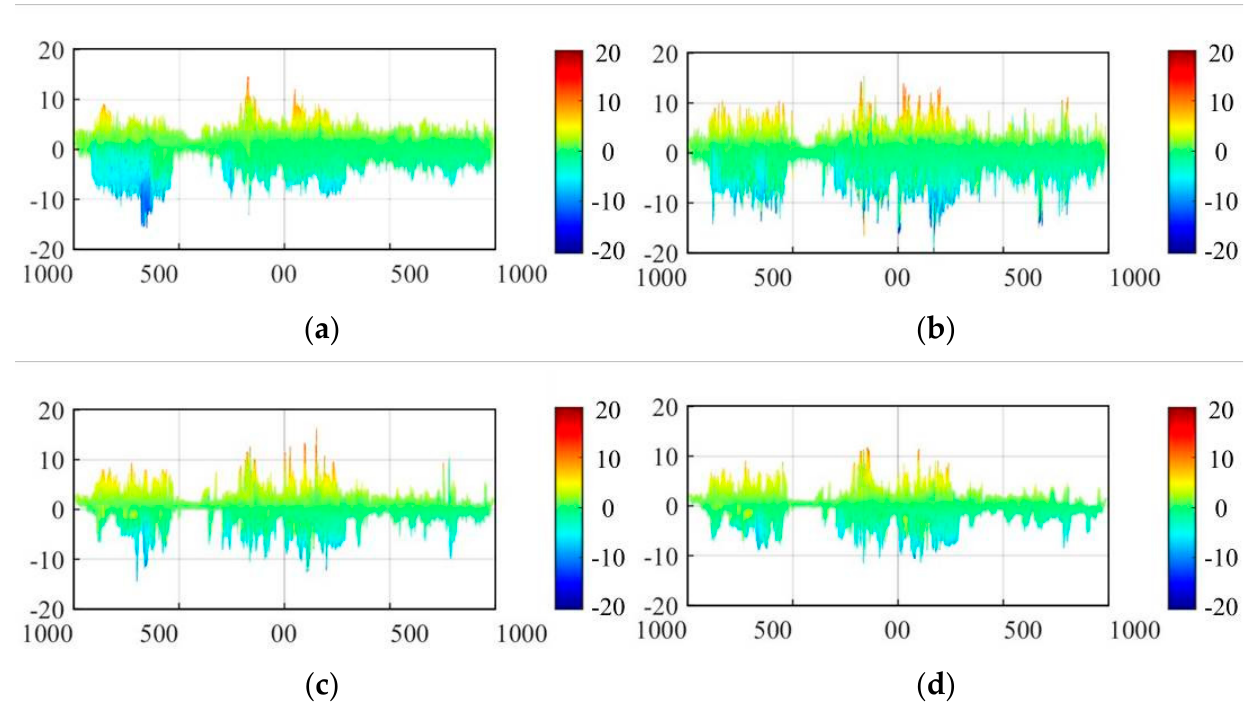
Figure 11. The unwrapping error display of different methods by adjusting the viewing angle of the 3D error map to ( − 45, 0): ( a ) difference between Figures 9b and 10a; ( b ) difference between Figures 9b and 10b; ( c ) difference between Figures 9b and 10c; ( d ) difference between Figures 9b and 10d. Note: unit of the color bar is rad.